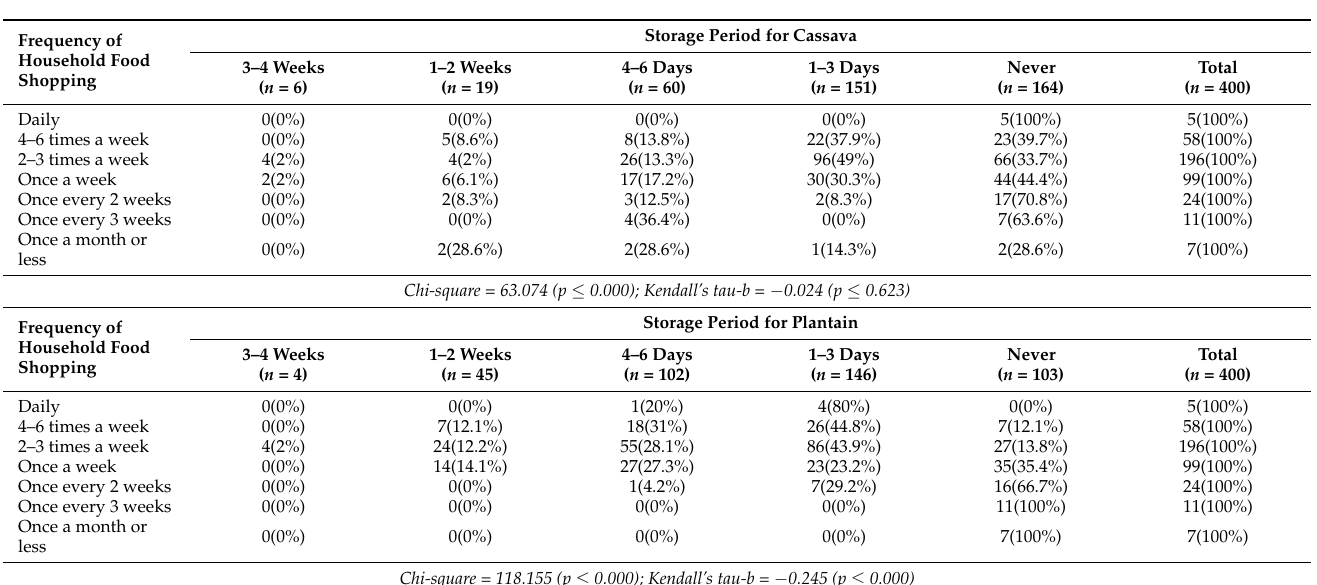
Figure 1. How often households shopped for food. Table 2. Relationship between frequency of household food shopping and storage of cassava and